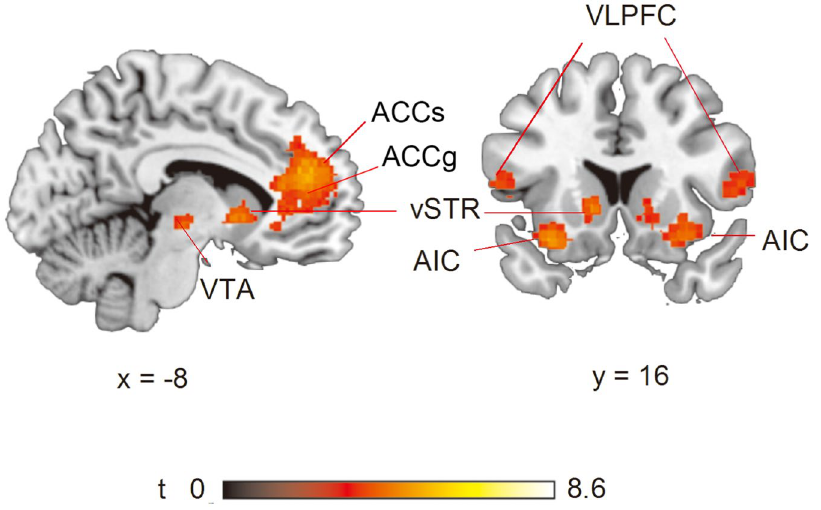
Figure 2. Effect of choice. Significantly greater activation induced when proposers chose a slightly selfish offer over a fair